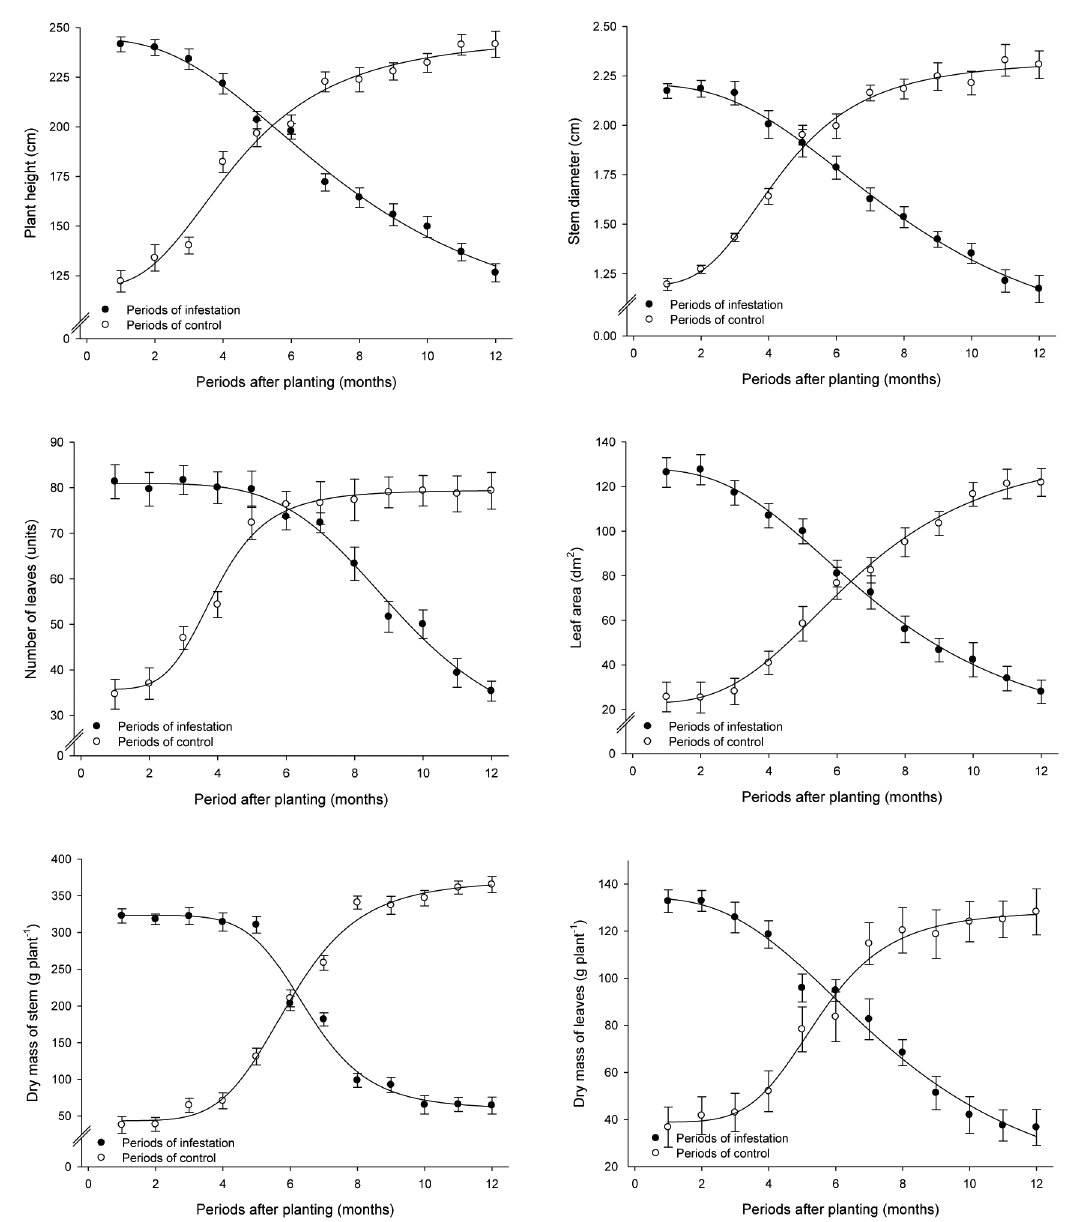
Figure 1 - Plant height, stem diameter, leaf number, leaf area, stem dry mass and leaf dry mass 12 months after planting of Hevea brasiliensis submitted to crescent periods of weed infestation or weed control. Vertical bars indicate the standard error of the